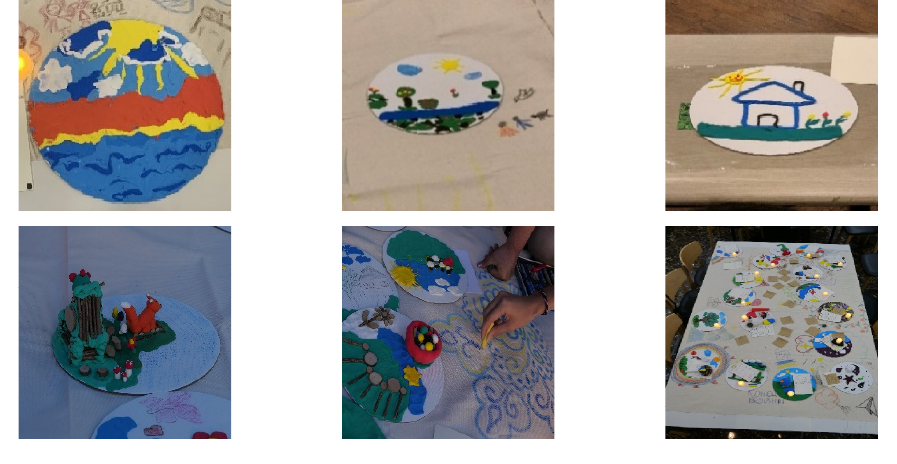
Figure 2. Participants’ artwork.